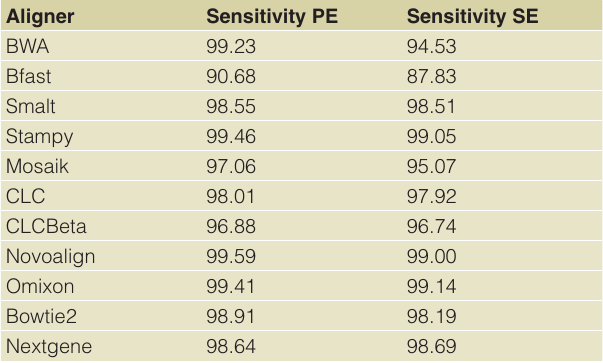
Figure 1. Overall sensitivity of downstream mutation detection. Graphical representation of the total percentage of mutations detected across of 67 groups of simulated Illumina reads following alignment in single-end and paired-end mode with each aligner. Table 3. Overall detection sensitivities. The total percentage of mutations detected post-alignment across the 67 groups of simulated Illumina reads was recorded for single and paired-end run-modes. Each read group contained 13 INDELs of varying sizes as well as 20